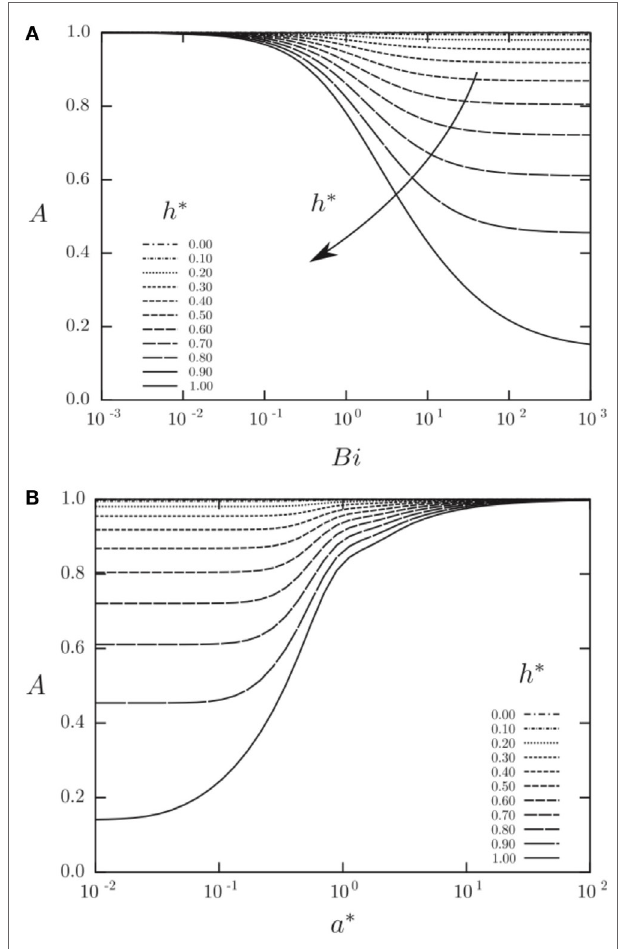
FiGURe 12 | Augmentation ratio, A = ( ) /h T h T ∆∆ ∆∆ , in a planar 1-D convective-conductive domain with an isoflux outer boundary condition (q 0)  ′′ == as a function of heat transfer coefficient fluctuation intensity ( h * = h a / h o ; where the sinusoidally varying heat transfer coefficient is: h ( t ) = h o + h a sin ω t ), Biot number (Bi = h o a / k ) and Fourier number ( a * = a / δ = π 0.5 /Fo 0.5 ) . Reproduced with permission from Mathie and Markides